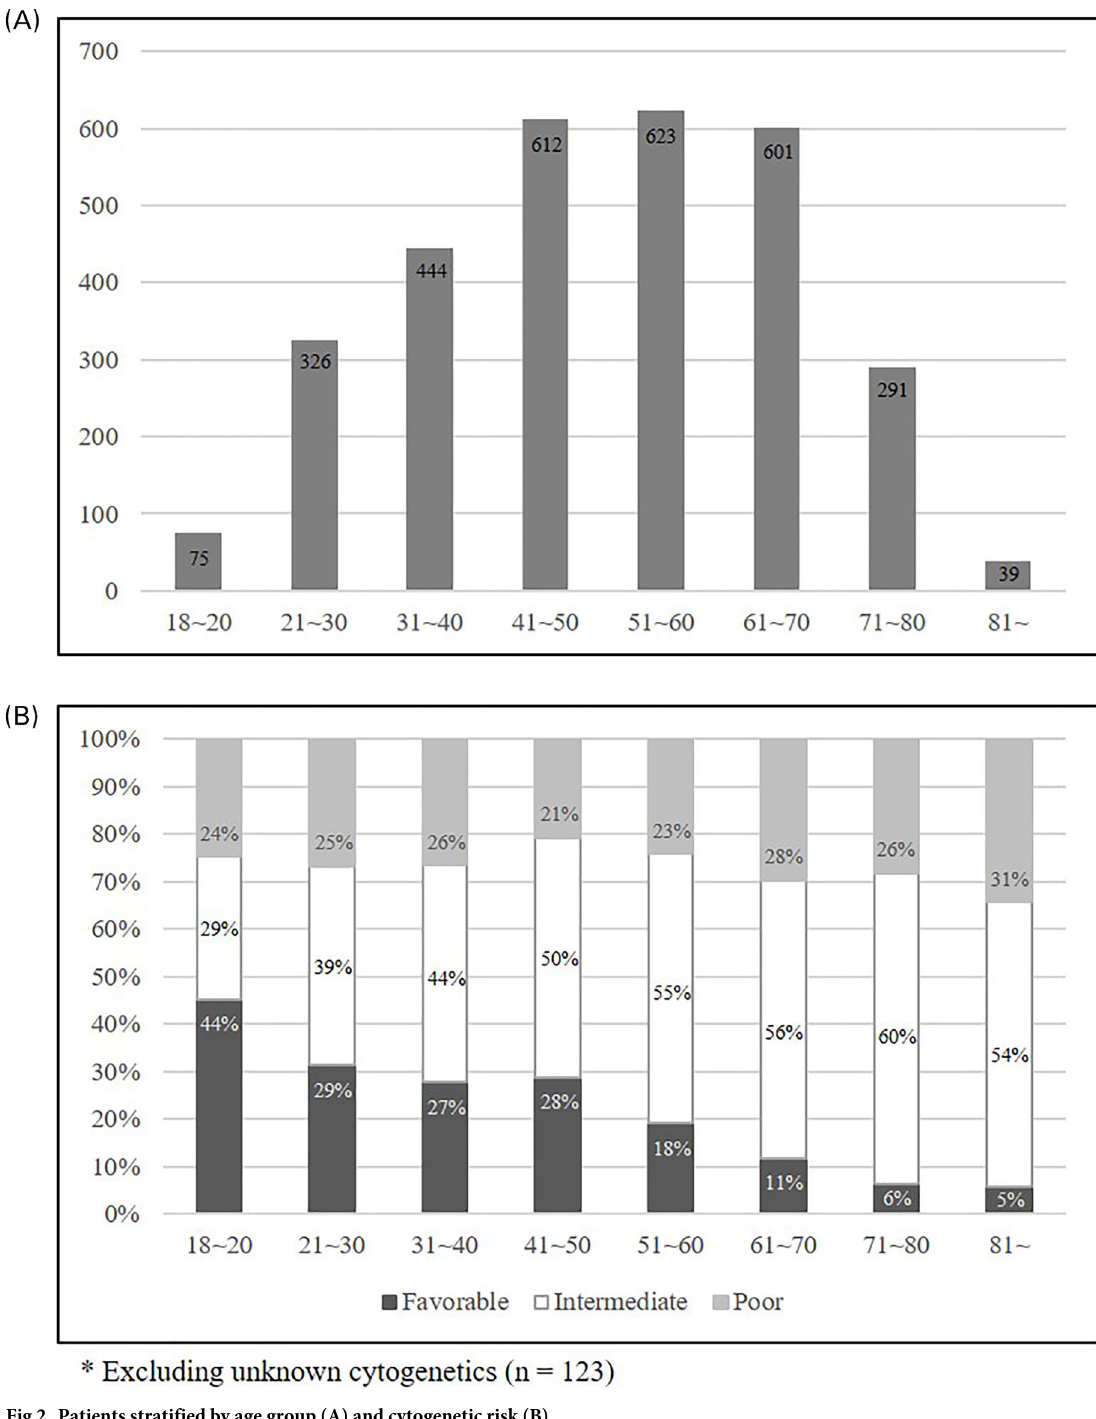
Fig 2. Patients stratified by age group (A) and cytogenetic risk (B).